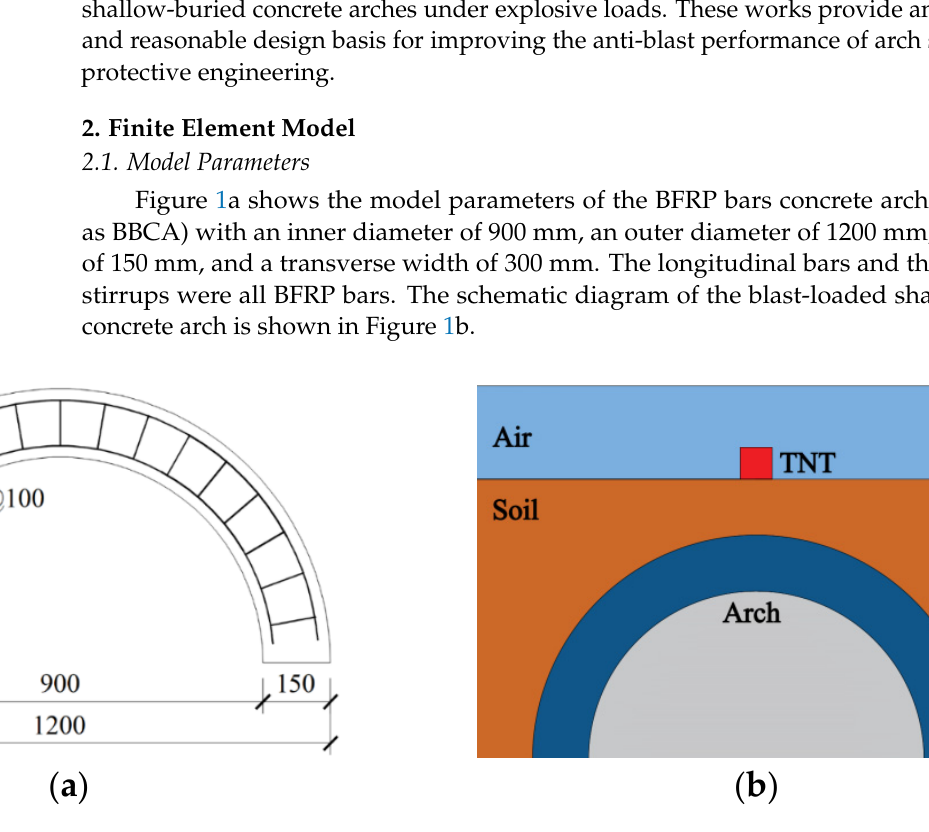
Figure 1. Schematic diagram of the BBCA component: ( a ) parameters of the BFRP reinforcement cage (mm), and ( b ) shallow buried protective concrete arch.